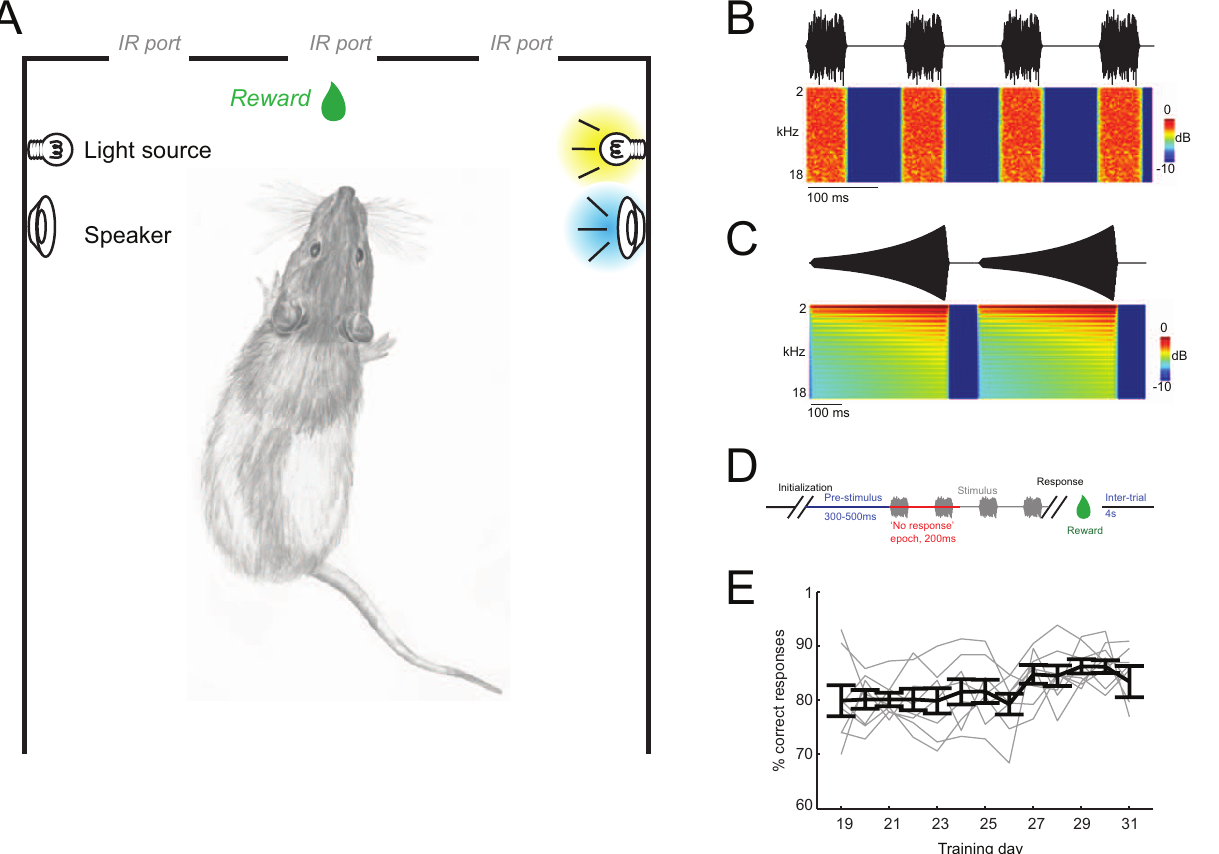
Figure 1. Training setup and stimuli. A) Schematic of the training setup indicating three infra-red sensitive nose-pokes, a tube for reward- delivery and the lateralized visual and acoustic stimuli. Stimuli were presented on either side and in one of three modality conditions (visual only, auditory only, audio-visual). B) Sound wave (upper) and time-frequency representation (lower panel) for the auditory white-noise stimulus. Noise pulses lasted 60 ms with 80 ms inter-pulse intervals. C) Sound wave and time-frequency representation for auditory looming sounds. Individual looming sweeps lasted 500 ms and were separated by 100 ms intervals. D) Schematic of trial timing. Trial initialization by the animal was followed by a pre-stimulus period (300–500 ms) subsequent to which the stimulus appeared on either side. The first 200 ms of stimulus presentation were defined as no-response epoch during which responses were ‘punished’ by time-outs. E) Behavioral performance (% correct responses) for the first days during the final training stage (Step 6). The animals reached stable performance above 80% in few days of training on this step. Days are indicated relative to the total training time (including all steps).